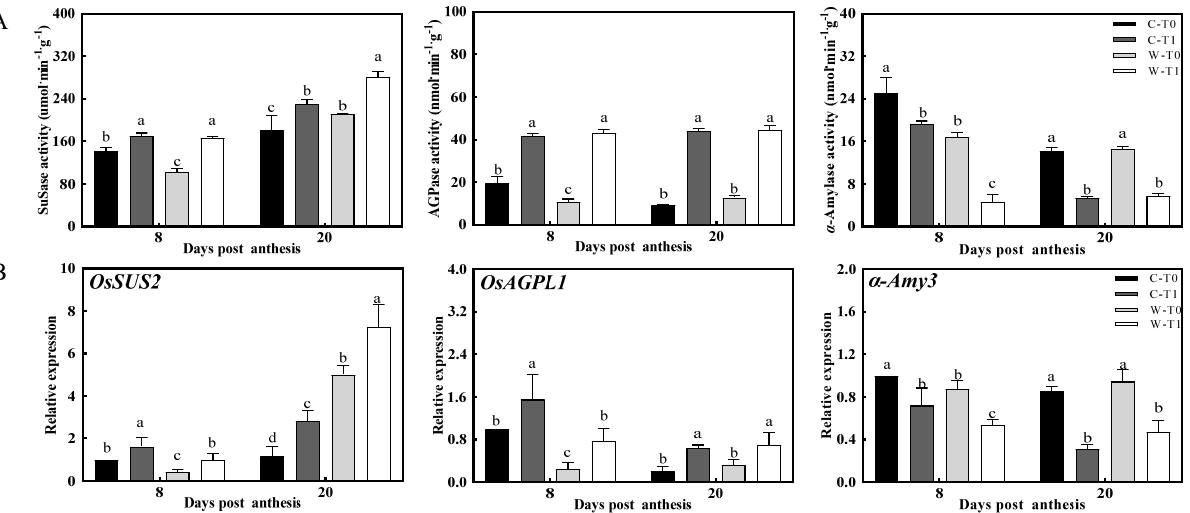
Figure 3. Activities of key enzymes and gene expression on carbohydrates’ metabolism of stems in 2020. ( A ) the activity of SuSase, AGPase, and α -Amylase in stem at 8 DPA and 20 DPA; ( B ) the expression of OsSUS2 , OsAGPL1 , and α -Amy3 were validated by RT-PCR; C, CJ03; W, W1844; T0, control group without any treatment; T1, top 2/3 of the spikelets were removed; different letters from the same character under the same DPA indicate significant differences at the p = 0.05 level.